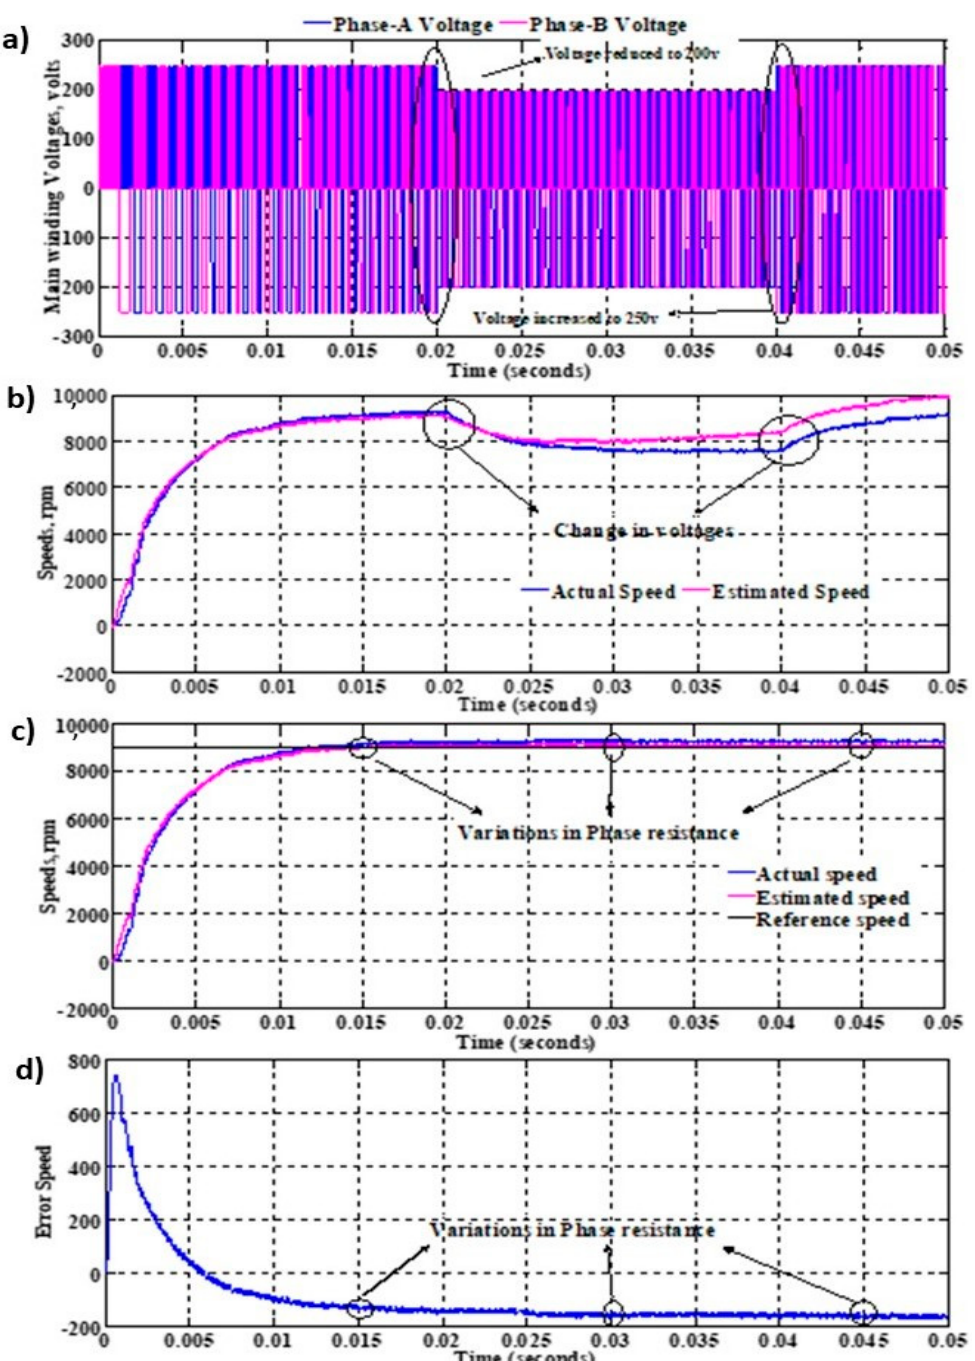
Figure 21. ( a ) Regulated main phase voltages, ( b ) estimated and actual speeds when changes in the supply voltage, ( c ) Estimated and actual speeds when changes in phase resistances, and ( d ) speed tracking error when the phase resistances are varied.